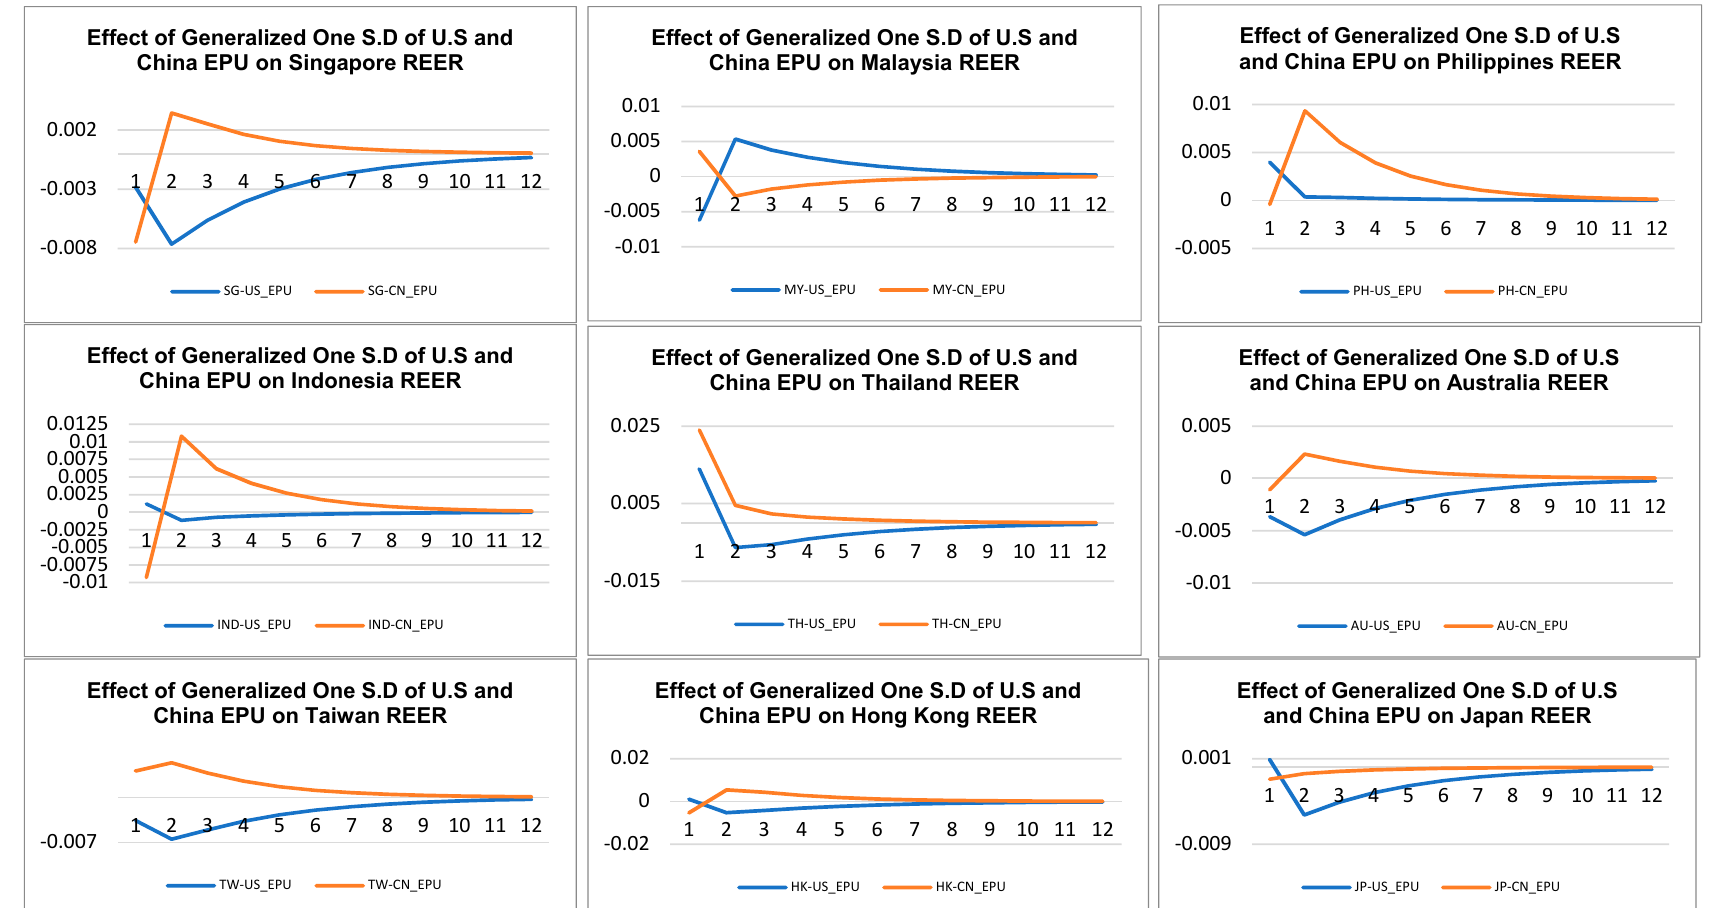
Figure 7. VAR estimations of impact of innovations of one standard deviation in the US and China economic policy uncertainty (EPU) on the APAC REERs.